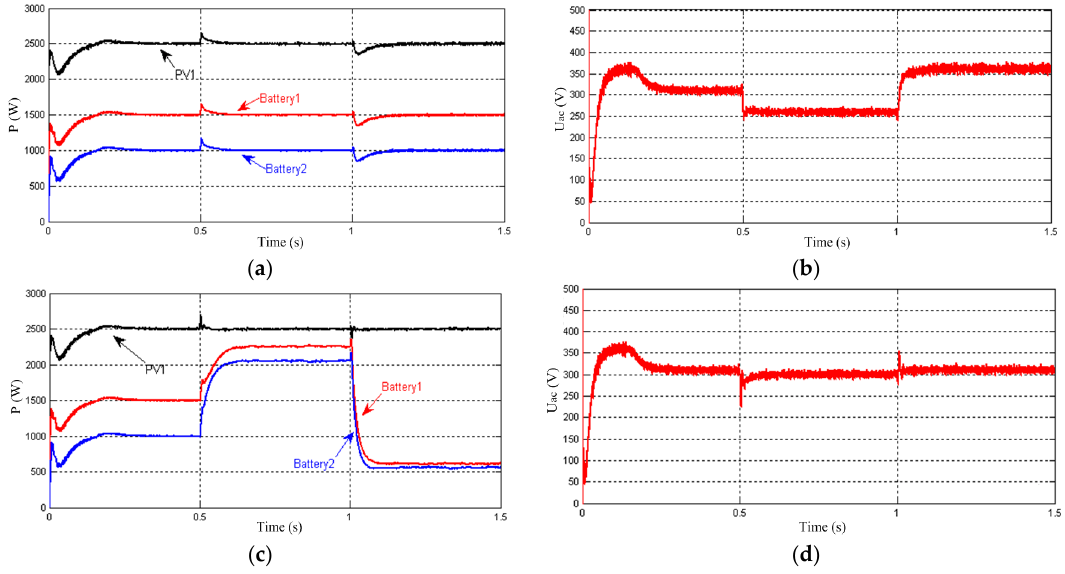
Figure 11. Simulated results of case 3: ( a ) output active power without Droop ‐ 1 and Droop ‐ 3 control; ( b ) AC bus phase voltage without Droop ‐ 1 and Droop ‐ 3 control; ( c ) output active power with proposed Droop ‐ 1 and Droop ‐ 3 control; and ( d ) AC bus phase voltage with proposed Droop ‐ 1 and Droop ‐ 3 control.